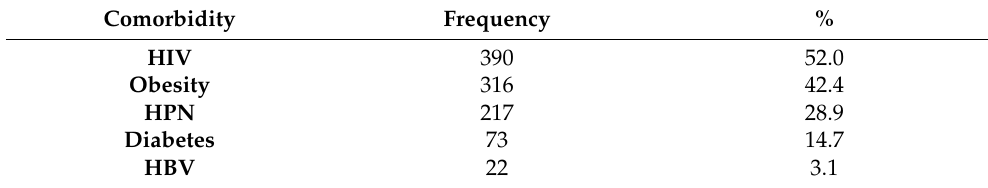
Table 2. Identified disease conditions.